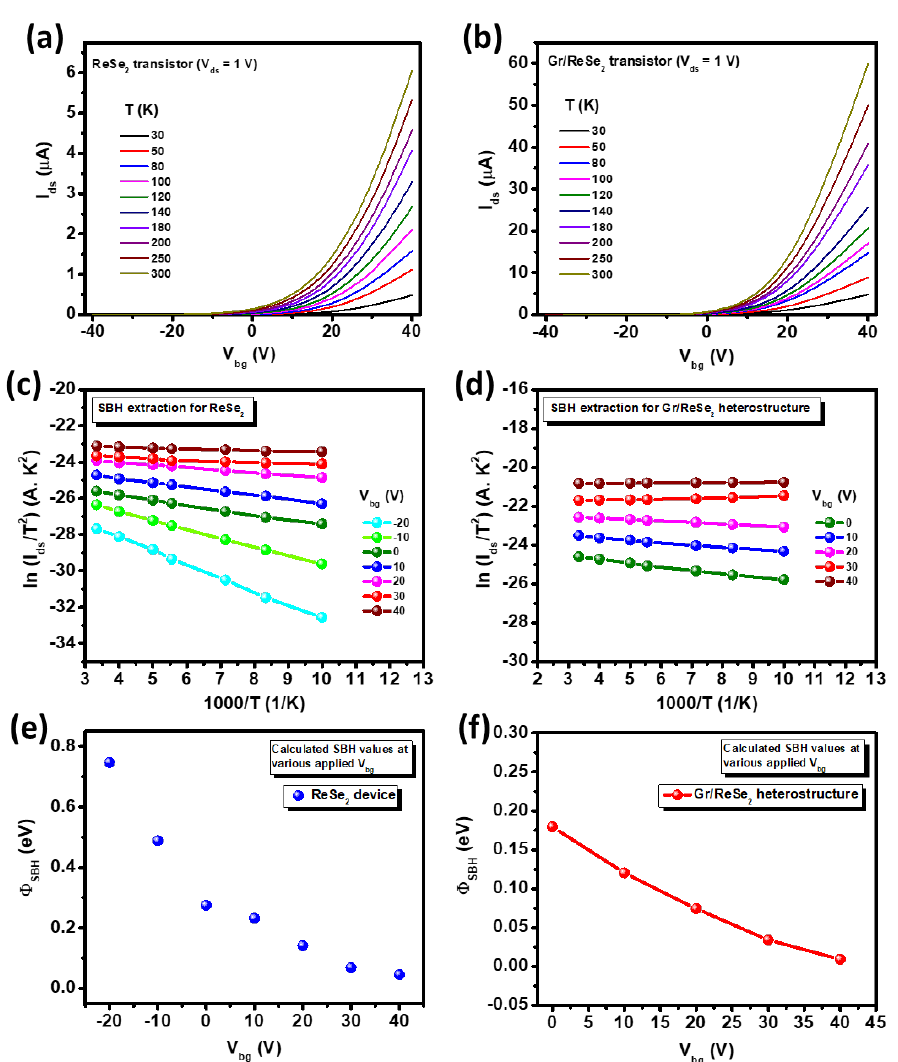
Figure 5. ( a ) Temperature-dependent transfer curves ( I ds – V g ) of ReSe 2 and ( b ) Gr/ReSe 2 transistors for temperature range 30–300 K and V ds = 1V. No MIT evidence is visible. Richardson plot between ln (I ds /T 2 ) and 1000/T at various V bg for ( c ) ReSe 2 device, and ( d ) Gr/ReSe 2 heterostructure device. ( e ) Extracted SBH values versus V bg for the ReSe 2 device. ( f ) Extracted SBH values versus V bg for Gr/ReSe 2 device.